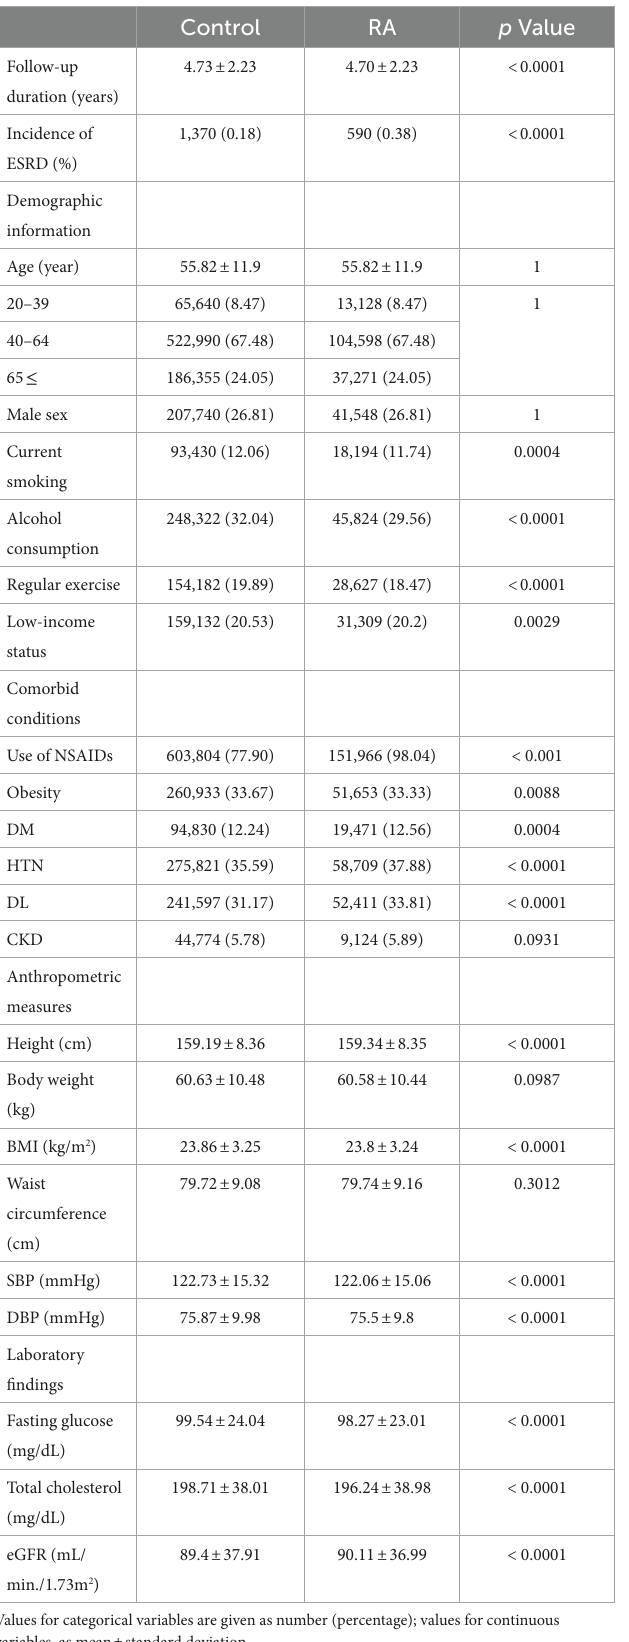
TABLE 1 Baseline characteristics of study population.